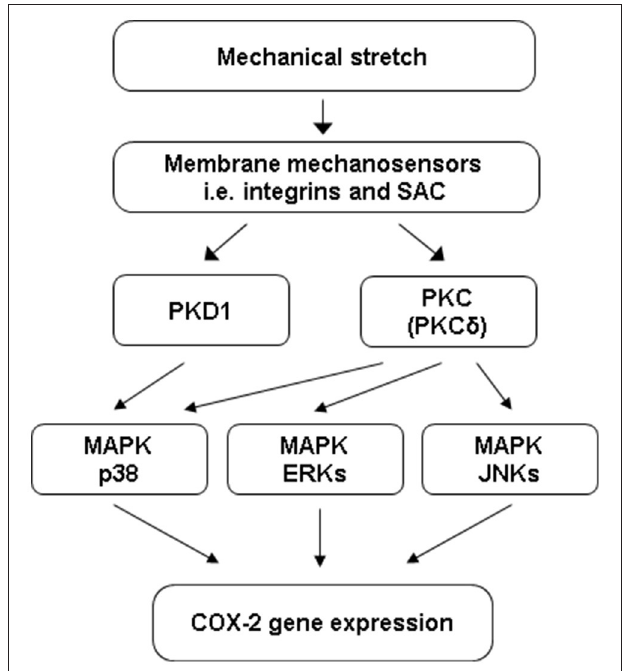
FIGURE 2 | Cell signaling mechanisms of mechano-transcription of COX-2 in colon SMC. Mechanical stretch on gut SMC is sensed by integrins and SAC (stretch-activated ion channels) at the cell membrane level. The mechano-sensors transduce mechanical stimulus to intracellular signaling pathways involving PKC (PKCdelta), PKD (PKD1), and MAPKs to induce mechano-transcription of COX-2 in colonic SMC. PKCdelta is coupled to MAPKs ERKs, p38, and JNKs, whereas PKD1 is coupled to MAPK